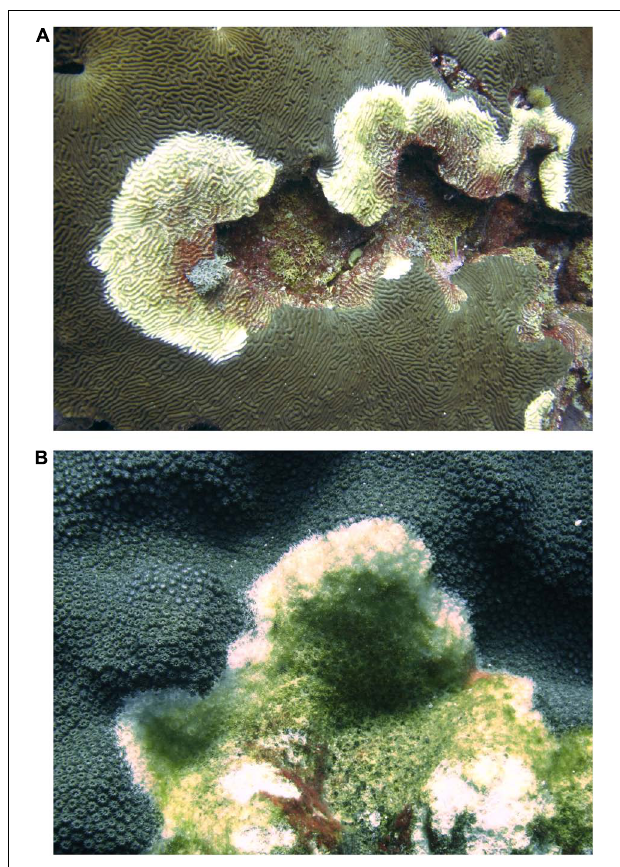
FIGURE 6 | Corals (A) Pseudodiploria strigosa , and (B) Orbicella faveolata with signs that resemble White Band Disease in East Flower Garden Bank at –18.3 m (–60 ft). Photos by